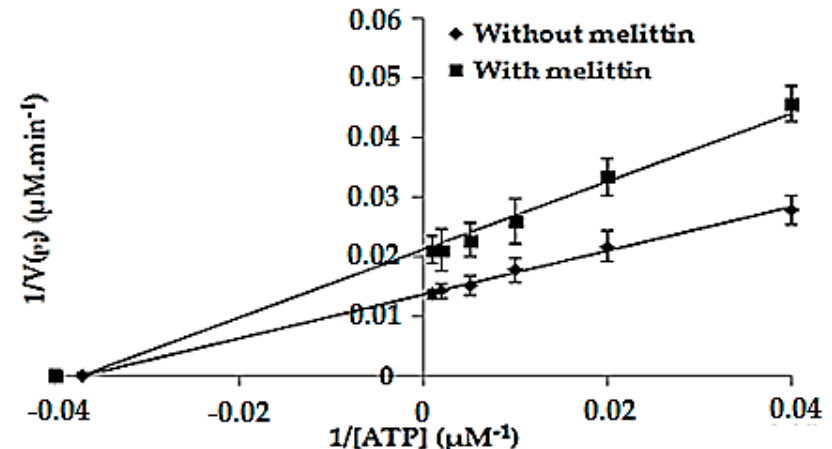
Figure 5. Lineweaver-Burk representation. The points of intersection with the x -axis of the linear regressions obtained without and with melittin correspond to − 1/K m and − 1/K ′ m , respectively while the points of intersection of these lines with the y-axes correspond to 1/V max and 1/V ′ max , respectively. Error bars show the standard deviation obtained from experiments done in triplicate .